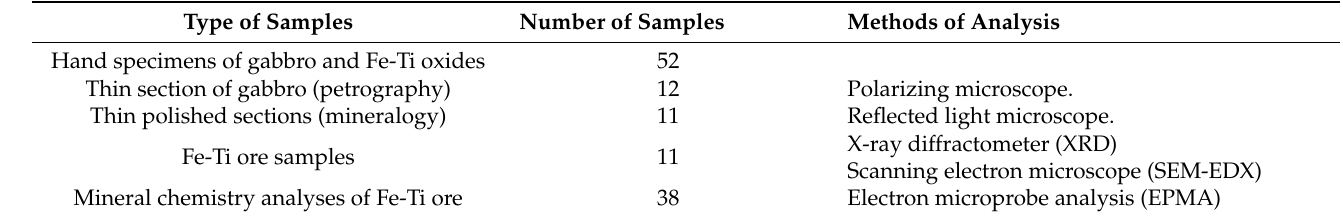
Table 1. The number and type of samples collected, as well as the analysis methods